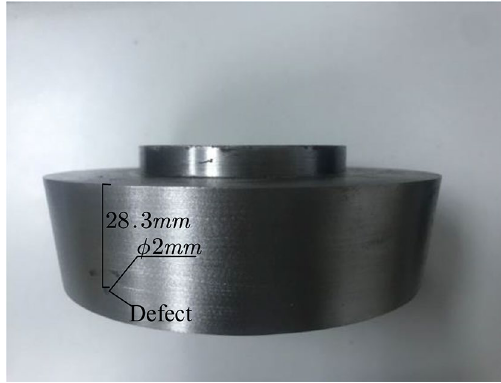
Figure 14. The superalloy disc sample.